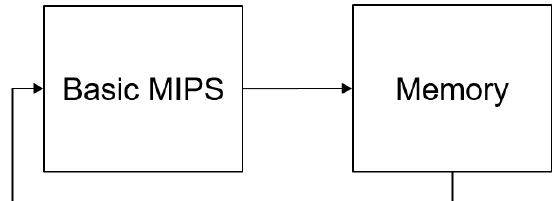
Figure 2. Temporal Software Redundancy (TSR) MIPS simplified block